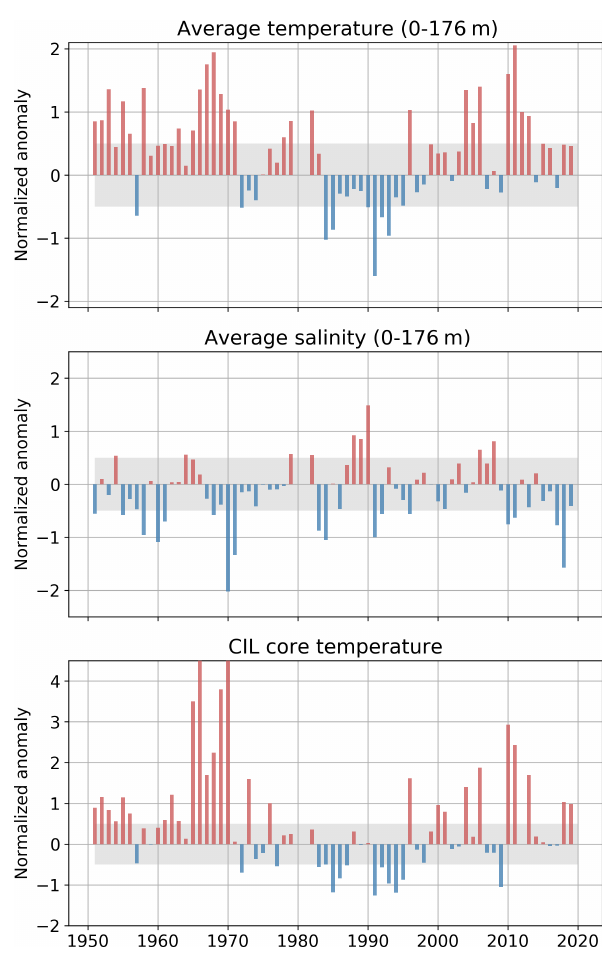
Figure A5. Same as Fig. 8 but using a climatology referenced to the 1981–2010